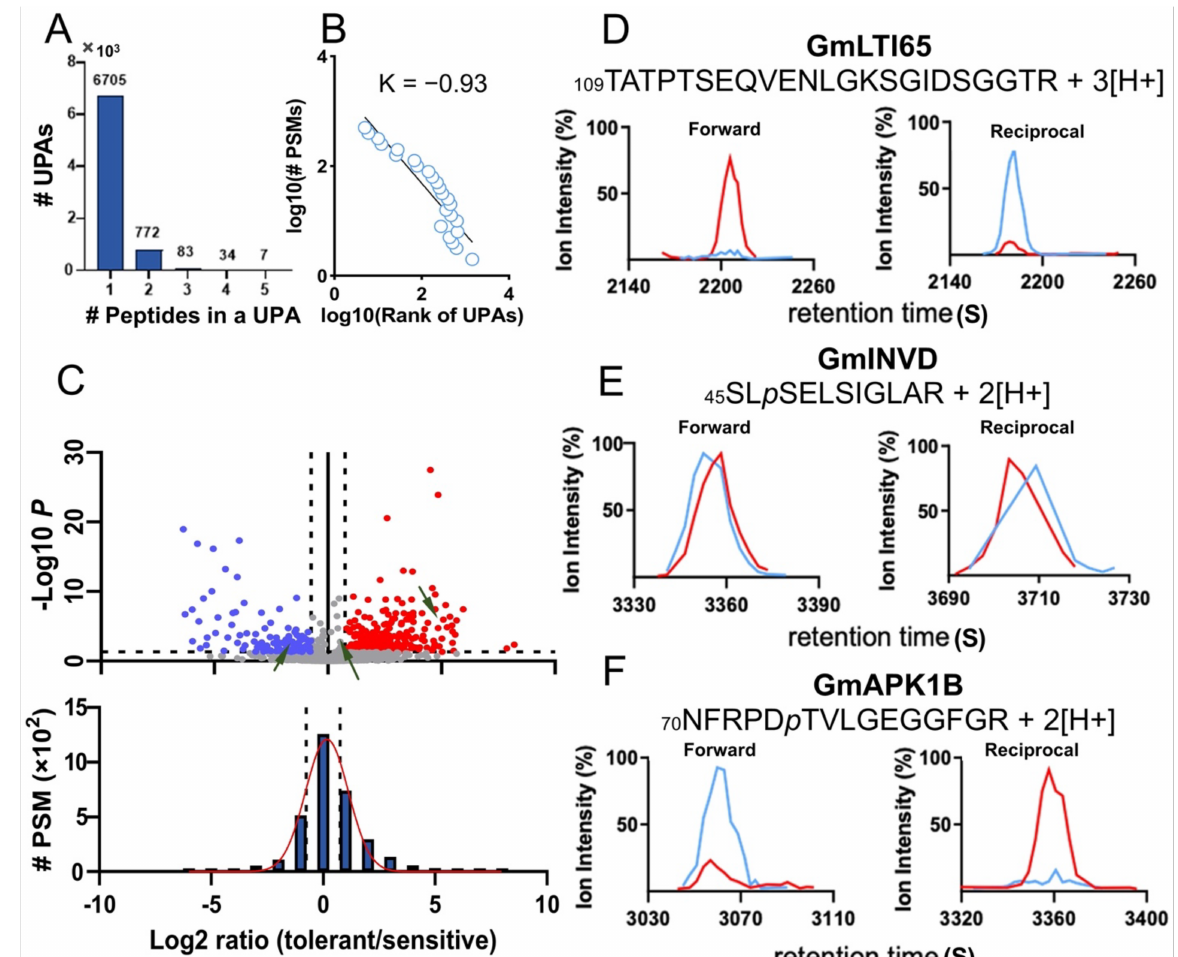
Figure 3. Quantitative proteomic analysis of the drought-tolerant soybean cultivar significantly regulated phosphopeptide groups under drought treatment. ( A ) Distribution and classification of phosphopeptide groups (or called UPAs, unique PTM peptide array, 7601 in total) according to the number of phosphopeptides present an UPA (Supplementary Table S5a). ( B ) The rank-frequency distribution of the number of PSMs over the index of UPAs (7601) according to Zipf’s law (Supplementary Table S5a). ( C ) Volcano plot (upper) and histogram (lower) of quantitative phosphoproteomics. The Log2 ratio is the average binary logarithmic ratio of MS1 isotopologue areas of phosphopeptides, and p is the p -value determined from Student’s t -test. The histogram of Log2 ratios are fitted using a normal distribution (red curve). The vertical and hori- zontal dashed line indicates the mean ± SD (standard deviation) of the distribution and the cut-off of Benjamini–Hochberg multiple hypothesis test corrected FDR ( ≤ 0.05), respectively (Supplementary Table S5b). ( D – F ) The red and blue circle repre- sents significantly up- and downregulated UPAs, respectively. ( D – F ) shows the XIC of increased, unchanged and decreased phosphopeptide ratio of drought-tolerant sample to the drought-sensitive sample, respectively. Forward and Reciprocal stands for the experimental replicate of F and R mixing of differentially isotope-labeled total cellular peptides, respectively. Subscript p marks the phosphosite within a measured phosphopeptide. Red lines represent the heavy isotope-labeled phosphopeptides while the blue lines represent the light isotope-labeled phosphopeptides. The number at the N-terminal end of phosphopeptide indicates the amino acid position within a phosphoprotein. The phosphosite and XIC shown in ( D – F ) are reproduced from soybean protein GmLTI65 (low-temperature-induced 65 kDa Protein, XP_003556105.1-S123), GmINVD (alkaline/neutral invertase D, XP_003536372.1-S47) and GmAPK1B (protein kinase 1B, XP_003523529.1-T75) listed in the Supplementary Table S5b,